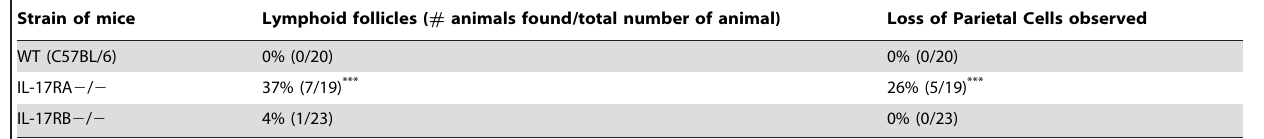
Table 1. Histological findings in H. pylori- infected mice (strain SS1).